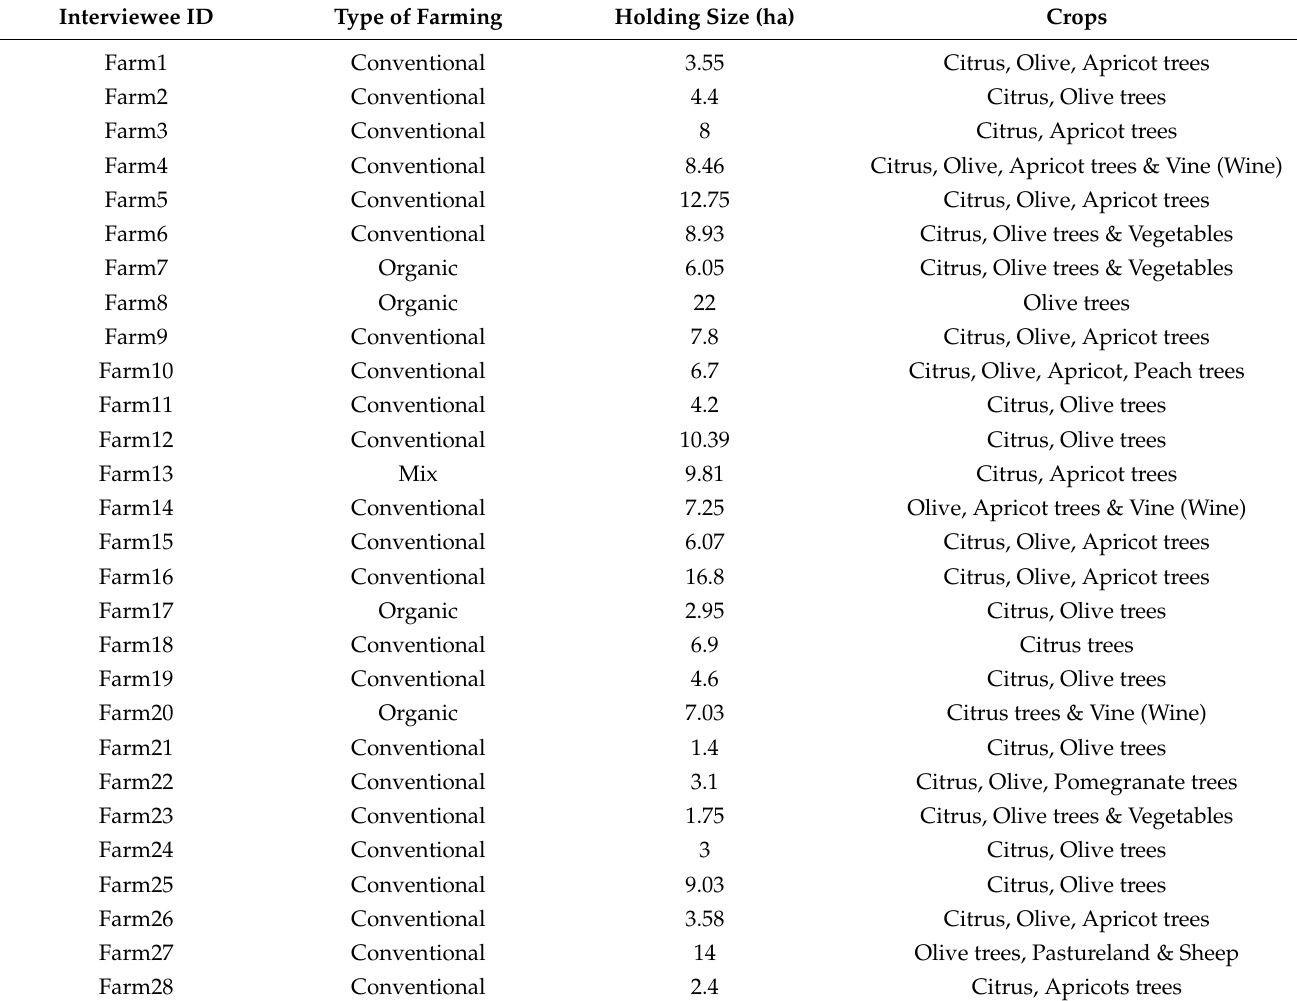
Table 2. Selected sample from FADN Greece. Adapted from FADN dataset Greece.